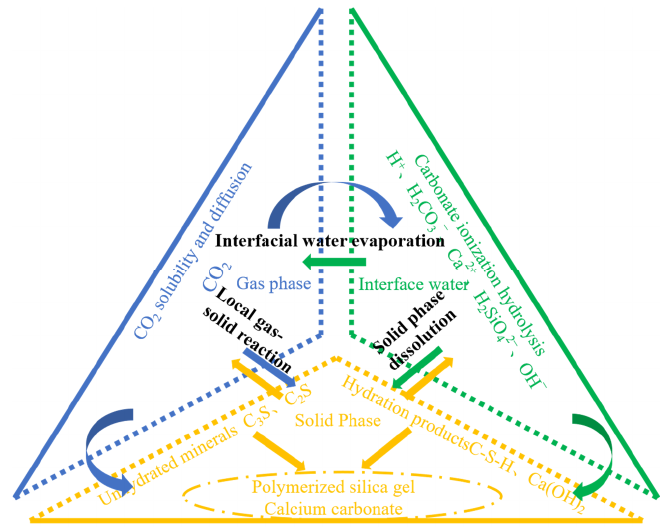
Figure 2. Reaction kinetics of CO 2 -cured concrete.